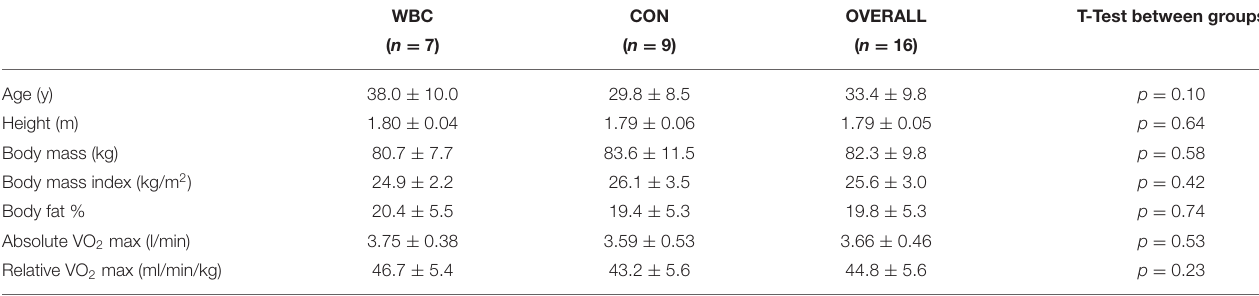
TABLE 1 | Summary of characteristics for whole body cryotherapy (WBC) and control (CON) participants in the training